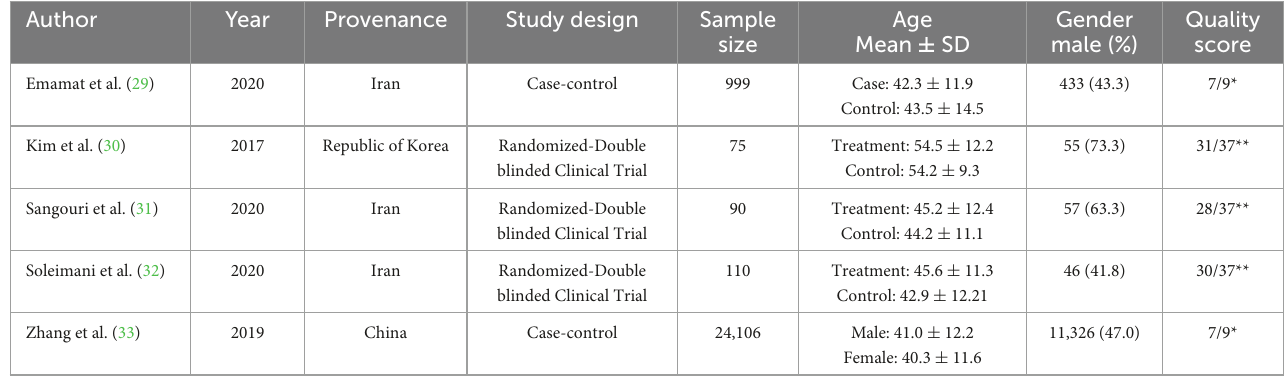
TABLE 1 Characteristics of studies that were included in the qualitative